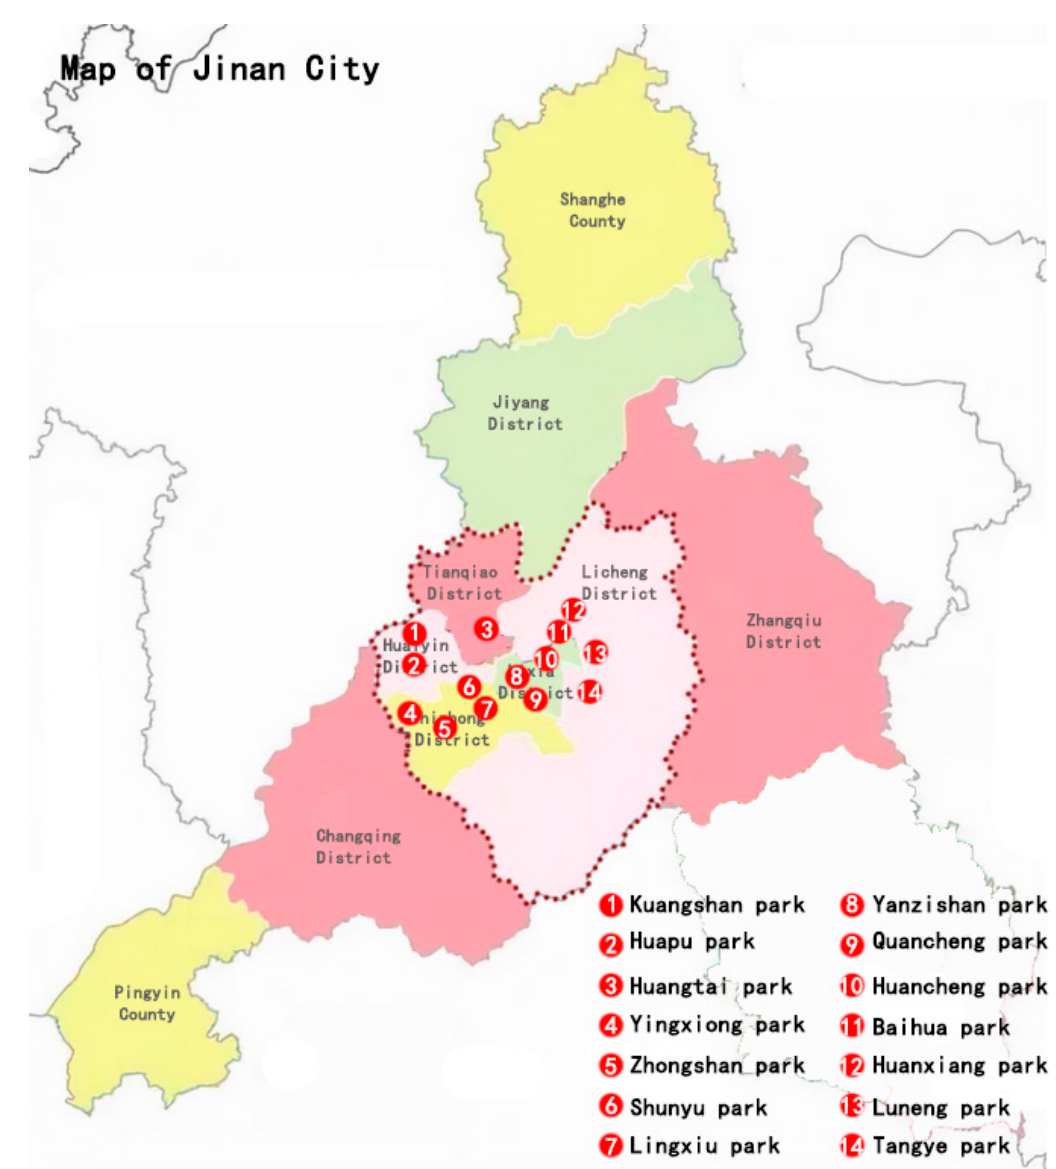
Figure 2. Location map of Jinan community parks.